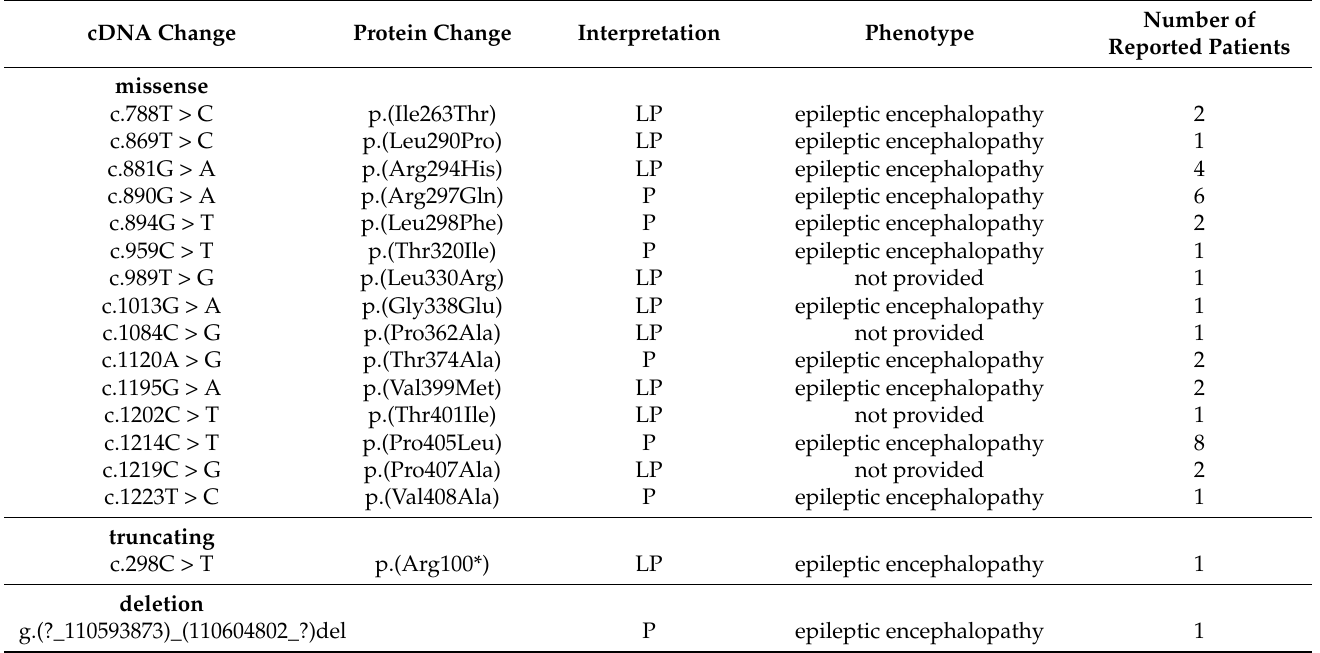
Table 2. Variants of KCNA2 reported in